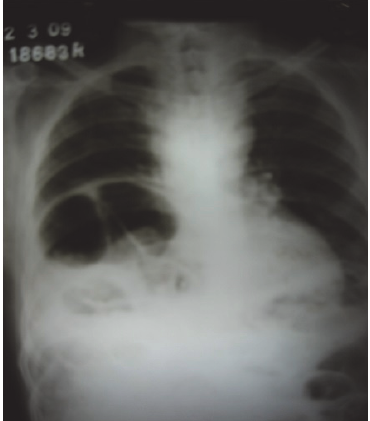
Figure 1: Chest X-ray showing an elevated right hemidiaphragm.